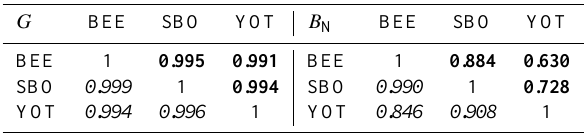
Table 5. Correlation matrix between stations for measurements (up- per right part of the matrix, in bold) and for McClear (lower left part, in italic) for G and B N